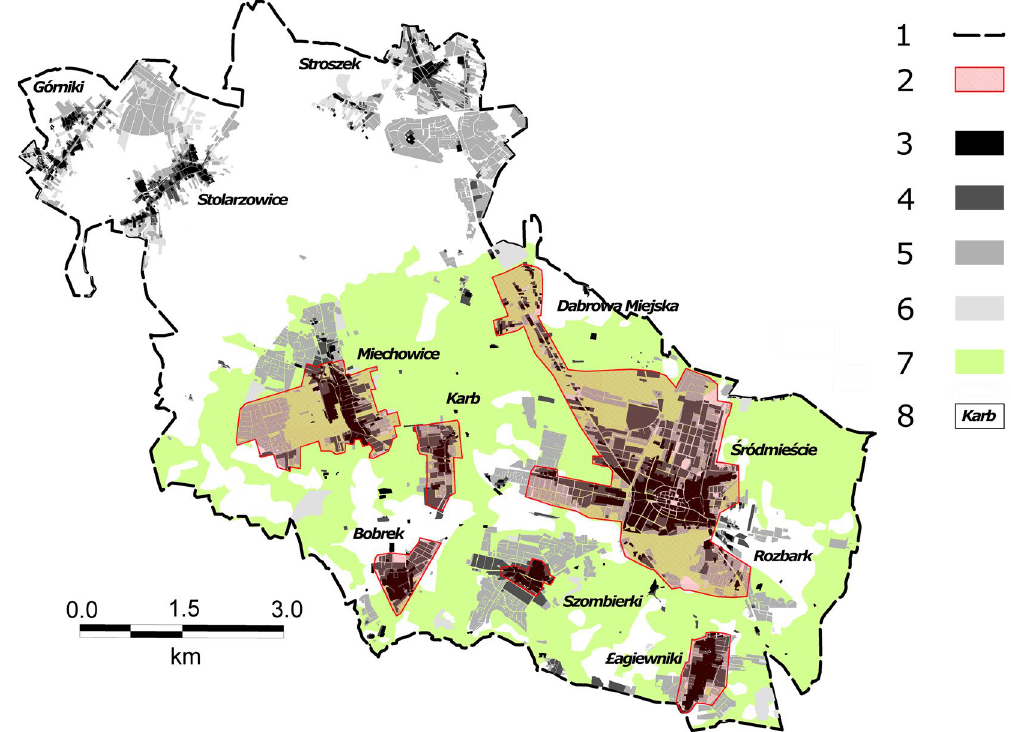
Figure 5. Land subsidence in the Bytom area in the years 1883–2011: 1—contemporary city limits; 2—built-up areas where mining damage and demolitions occurred; 3—built-up areas (as at 1883); 4—built-up areas (as at 1934); 5—built-up areas (as at 1994); 6—built-up areas (as at 2011); 7—range of land subsidence in the period 1883–2011; 8—city